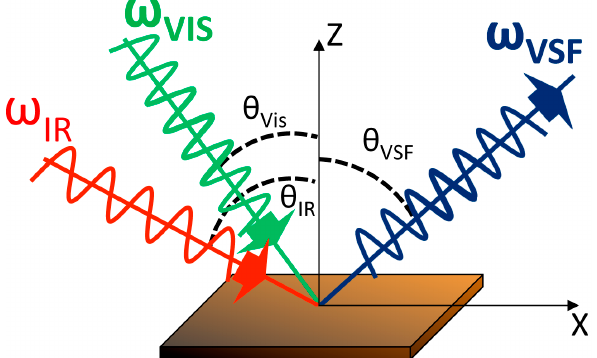
Figure 19. Schematic of the vibrational sum frequency spectroscopy (VSFS) geometry. The θ values represent the incident or reflected angles from the surface normal for visible, IR, and VSF beams. Each of the beams can be polarized perpendicular to the plane of incident (S-polarized) or parallel to it (P-polarized).